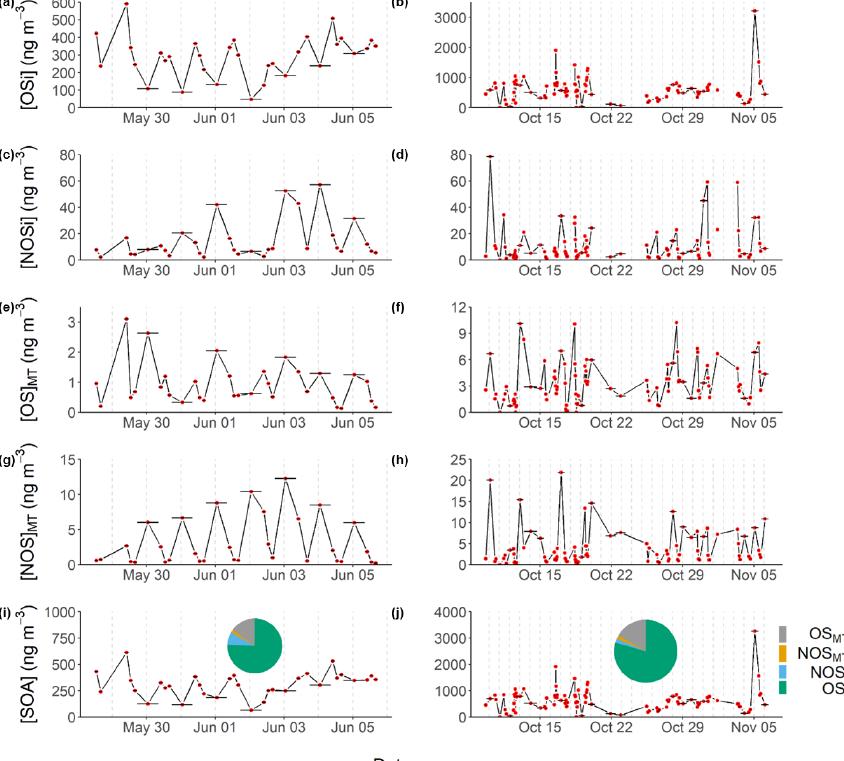
Figure 6. Time series across the pre- (a, c, e, g, i) and post-monsoon (b, d, f, h, j) campaigns of the quantified SOA tracers: OSi (a, b) , NOSi (c, d) , OS MT (e, f) , NOS MT (g, h) , and the sum of all SOA tracers (i, j) with the average campaign contributions. The vertical dotted lines represent midnight for each day. Only species identified in more than 40% of the samples for each campaign were